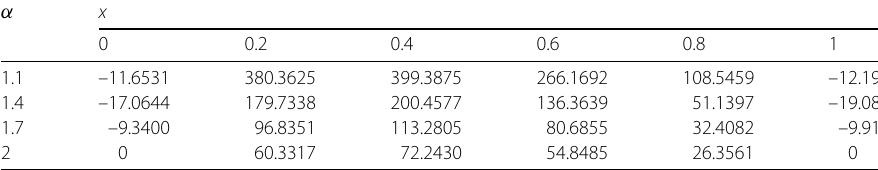
Table 2 Steady-state solutions to fractional order α ∈ (1,2] varying x ∈ [0,1] using RLFDO α x 0